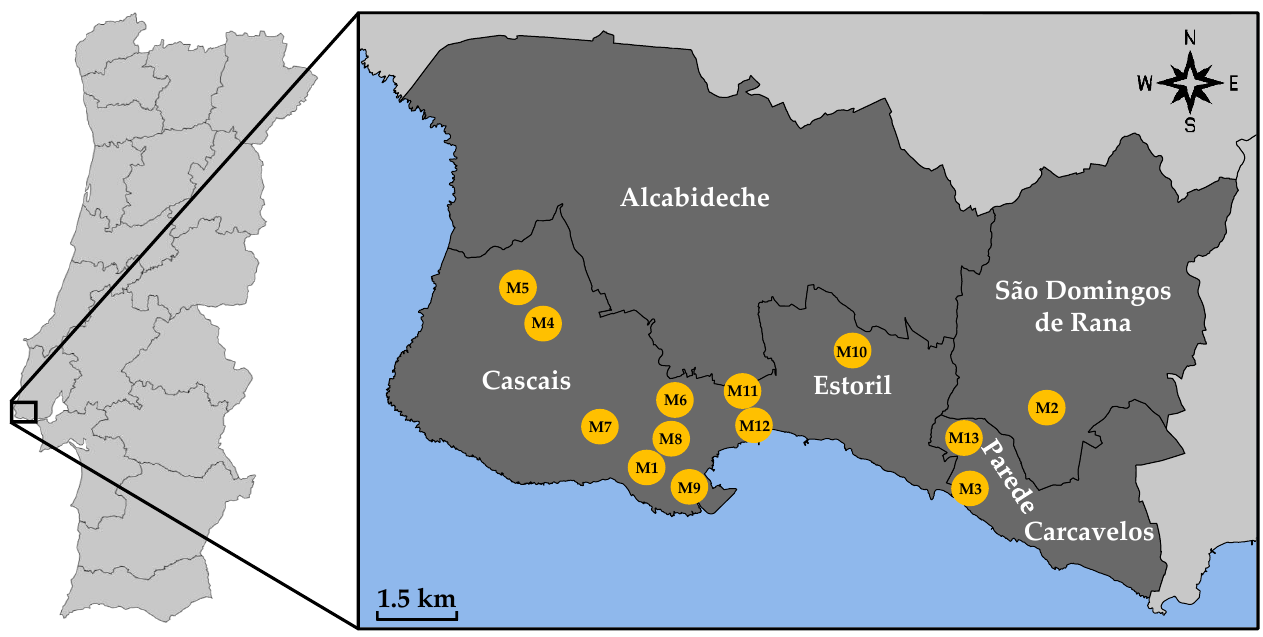
Figure 1. Locations of the 13 studied GSs in the Cascais municipality (delimitation defined by dark grey area), within the Lisbon metropolitan area.